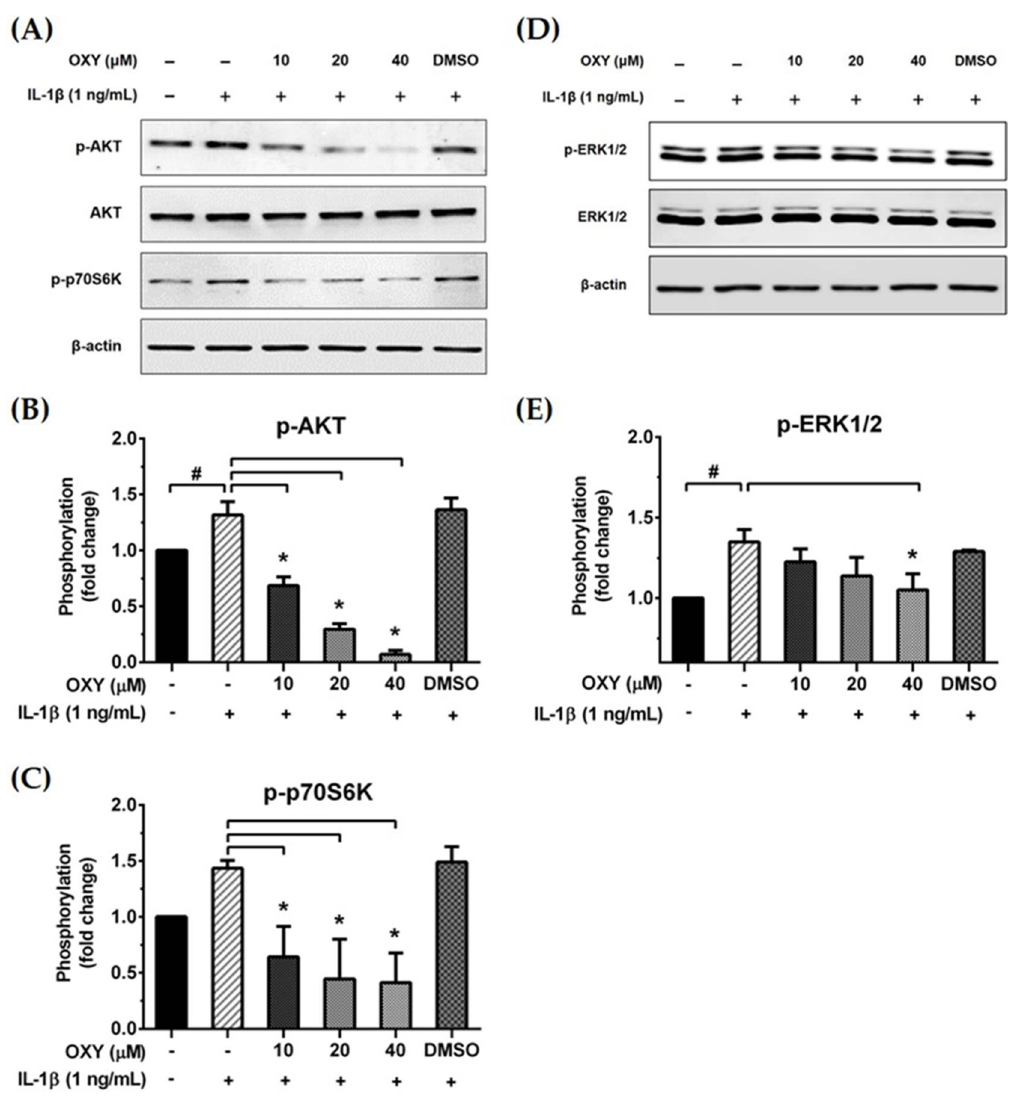
Figure 5. ( A and D ) Western blot analysis for the inhibitory effects of OXY on the phosphorylation of AKT, p70S6K, and ERK1/2 in cells treated with various concentrations of OXY (10, 20, and 40 μM) for 4 h before stimulation with IL-1β for 20 min; ( B ) quantitative analysis for AKT phosphorylation at Ser473; ( C ) quantitative analysis for p70S6K phosphorylation; ( E ) quantitative analysis for ERK1/2 phosphorylation. Total AKT, total ERK1/2, and beta actin (β-actin) were detected and used as an internal control. Data are represented as mean ± SD of three independent experiments; # p < 0.05 (compared to the untreated group) or * p < 0.05 (compared to the IL-1β-treated group).